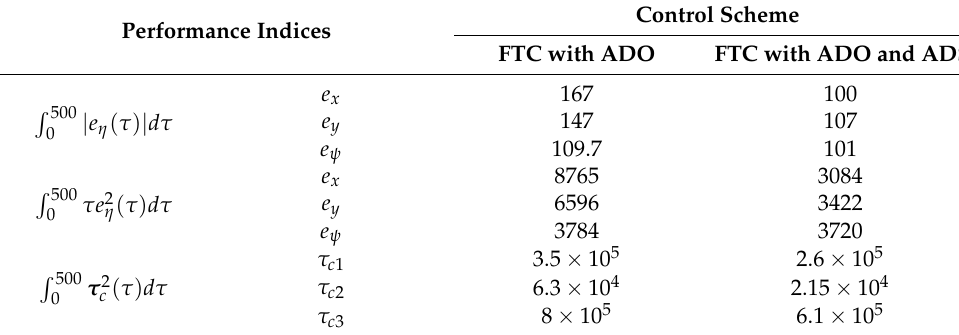
Figure 21. The force of each thruster. Table 3. Comparison of performance